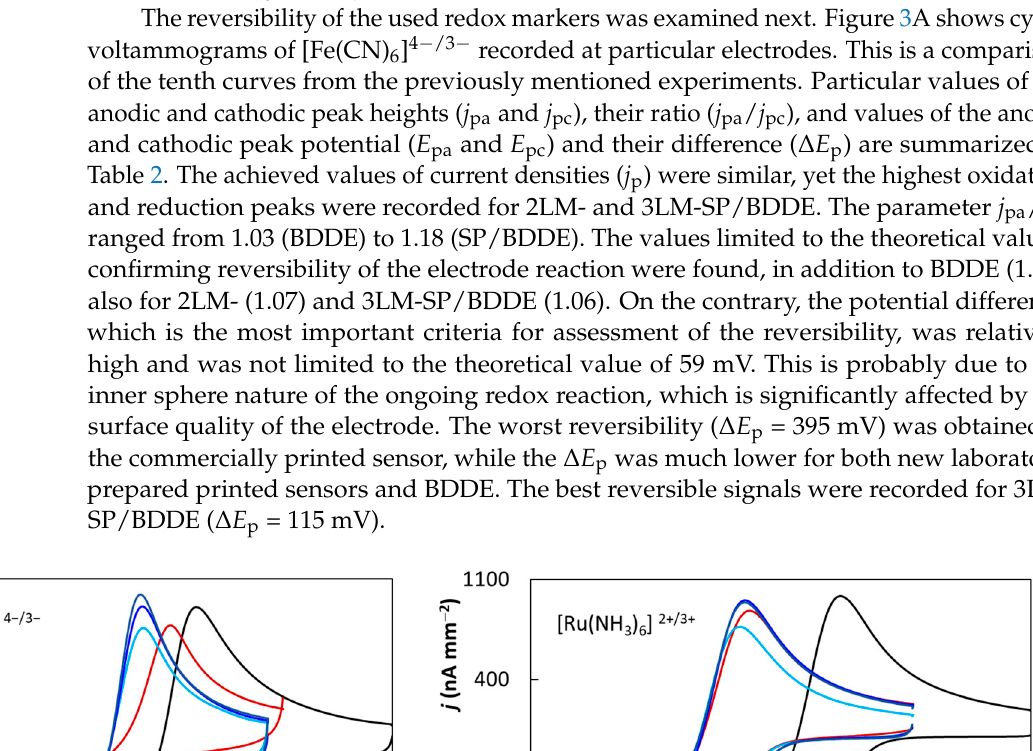
Last but not least, it is necessary to mention the significant potential shift of redox signals obtained on printed sensors, both commercial and laboratory-prepared, to less positive values in comparison with the classical three-electrode arrangement of an elec- trochemical cell. As documented in Figure S4A, this shift is caused by the pseudo-refer- ence electrodes used in the case of SPEs. The figure shows the example of 3LM-SP/BDDE; after connecting an external reference electrode instead of the printed one, the curve shifted, overlapping with the curve obtained on BDDE with the same reference electrode. A similar potential shift was observed throughout the work in the analysis of redox mark- ers as well as other analytes and will not be given further attention in the text. Similar experiments for the Ru complex are documented in Figure 3B, and the basic parameters of the obtained curves are summarized in Table 3. The parameter j pa / j pc ranged from 0.96 to 1.03 at all tested sensors, limiting to the theoretical value 1 and confirming reversibility of the electrode reaction. In contrast to [Fe(CN) 6 ] 4 − /3 − , in the case of [Ru(NH 3 ) 6 ] 2+/3+ , Δ E p values were found close to the theoretical value of 59 mV which is typical for the one-electron reversible electrode reaction. The lower values of Δ E p for this redox probe could be explained by the nature of the electrode reaction. The outer sphere reaction pathway and the electron transfer as well is in general not influenced by the phys- icochemical properties of the working surface of the electrode [53]. Excellent reversibility was confirmed, especially for LM-SP/BDDEs and classical BDDE ( Δ E p = 59–65 mV). For a commercial sensor, the potential difference was again greater ( Δ E p = 85 mV) compared to others.